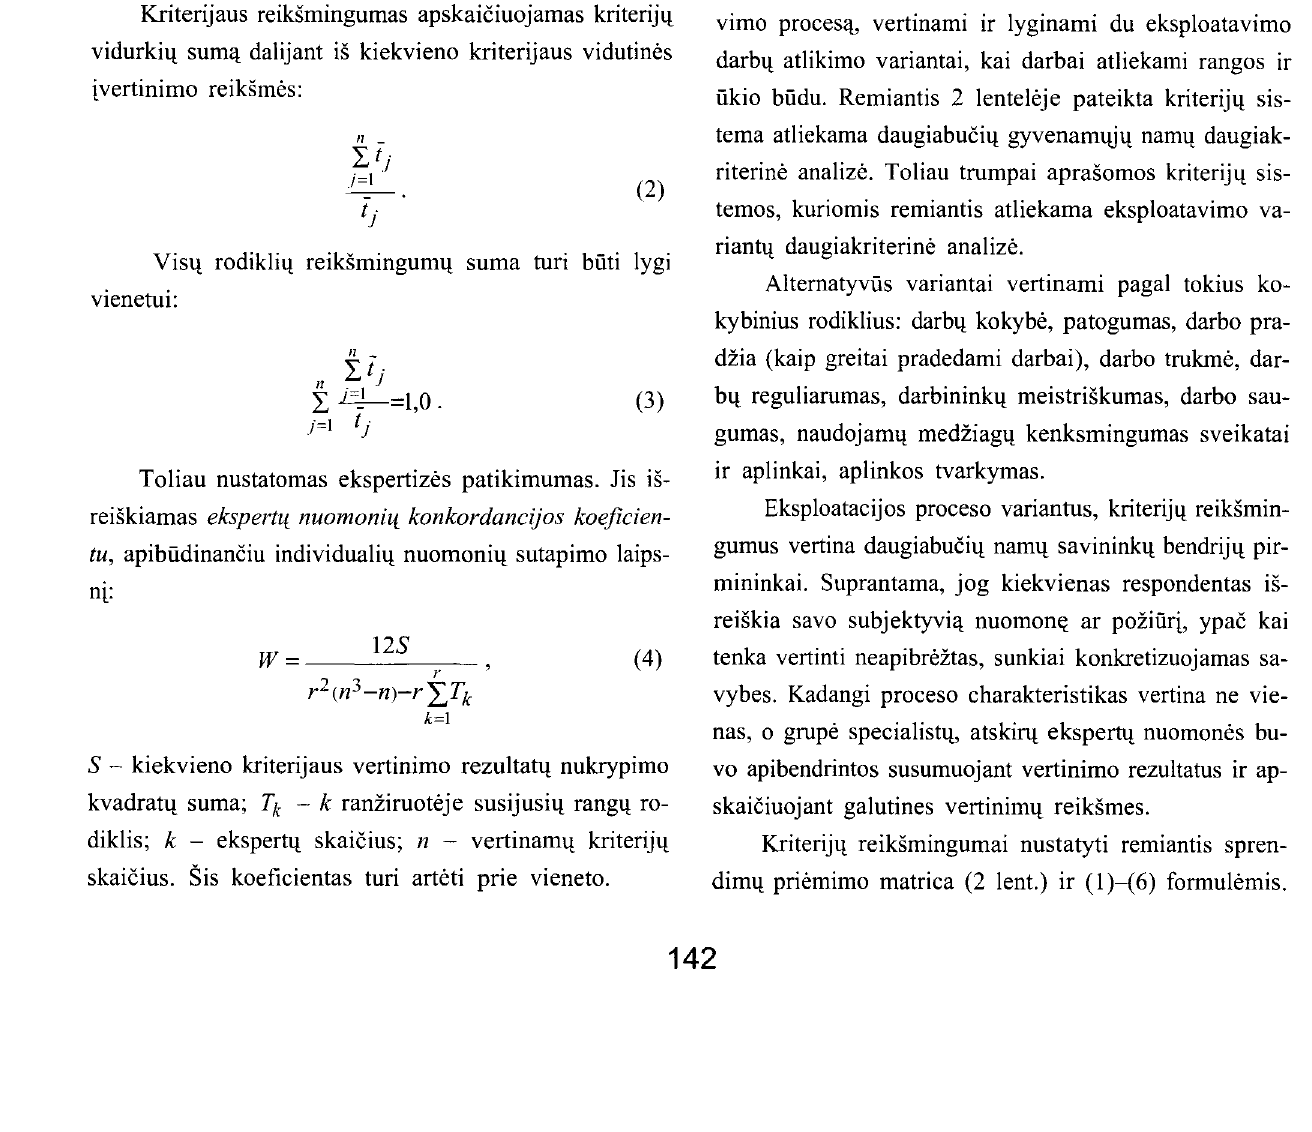
Fig 3. Block-scheme of expert evaluation method Kriterijaus reiksmingumas apskaiCiuojamas kriterijtt vidurkitt sum'l dalijant is kiekvieno kriterijaus